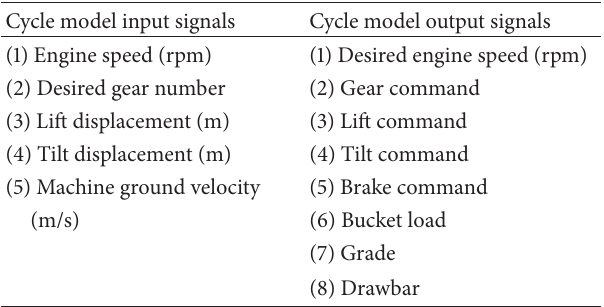
Table 2: Operator model signals.